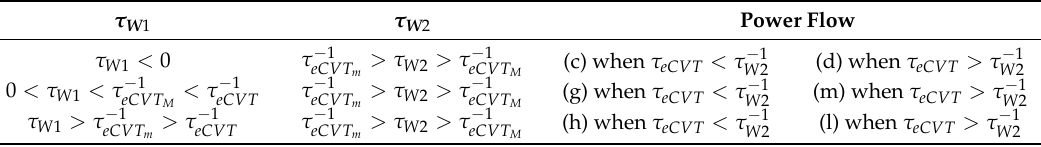
Table 5. Case 2—Power flows for each range of the planetary gear constants.